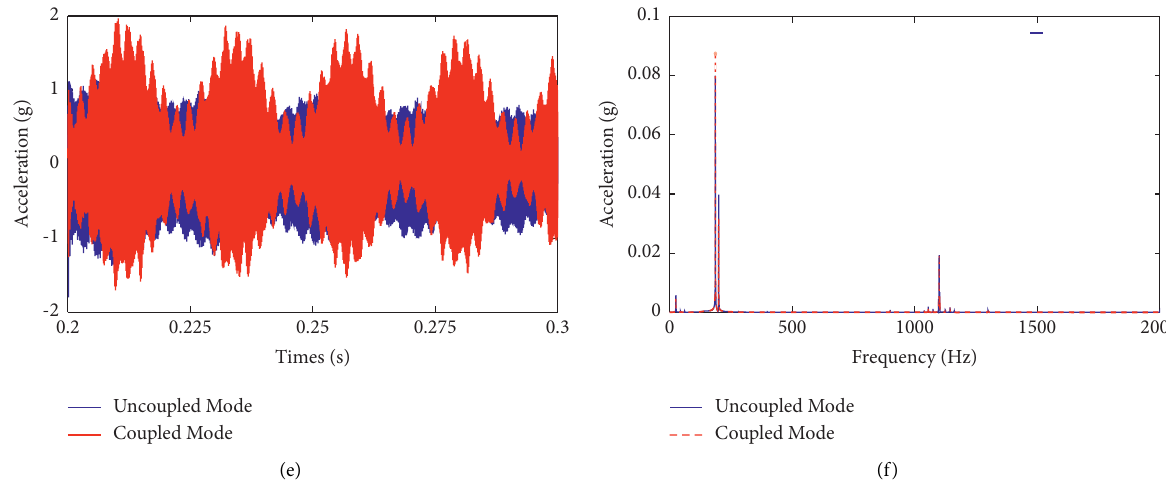
Figure 21: Influences of housing elasticity on the mass point bending vibration characteristics. (a) Bending vibration acceleration of gear A in the time domain. (b) Bending vibration acceleration of gear A in the frequency domain. (c) Bending vibration acceleration of gear B in the time domain. (d) Bending vibration acceleration of gear B in the frequency domain. (e) Bending vibration acceleration of gear E in the time domain. (f) Bending vibration acceleration of gear E in the frequency domain.